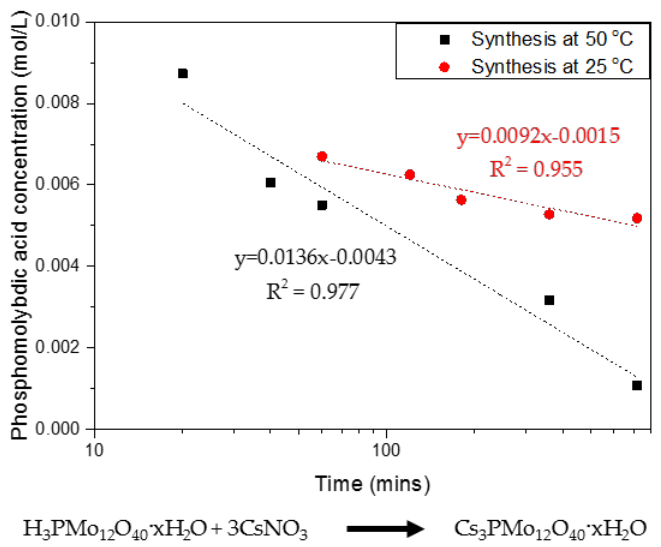
Figure 2. Rate of reaction showing first-order kinetics for the co-precipitation reaction of caesium nitrate and phosphomolybdic acid forming caesium phosphomolybdate (CPM) at 25 °C and 50 °C with corresponding reaction equation.